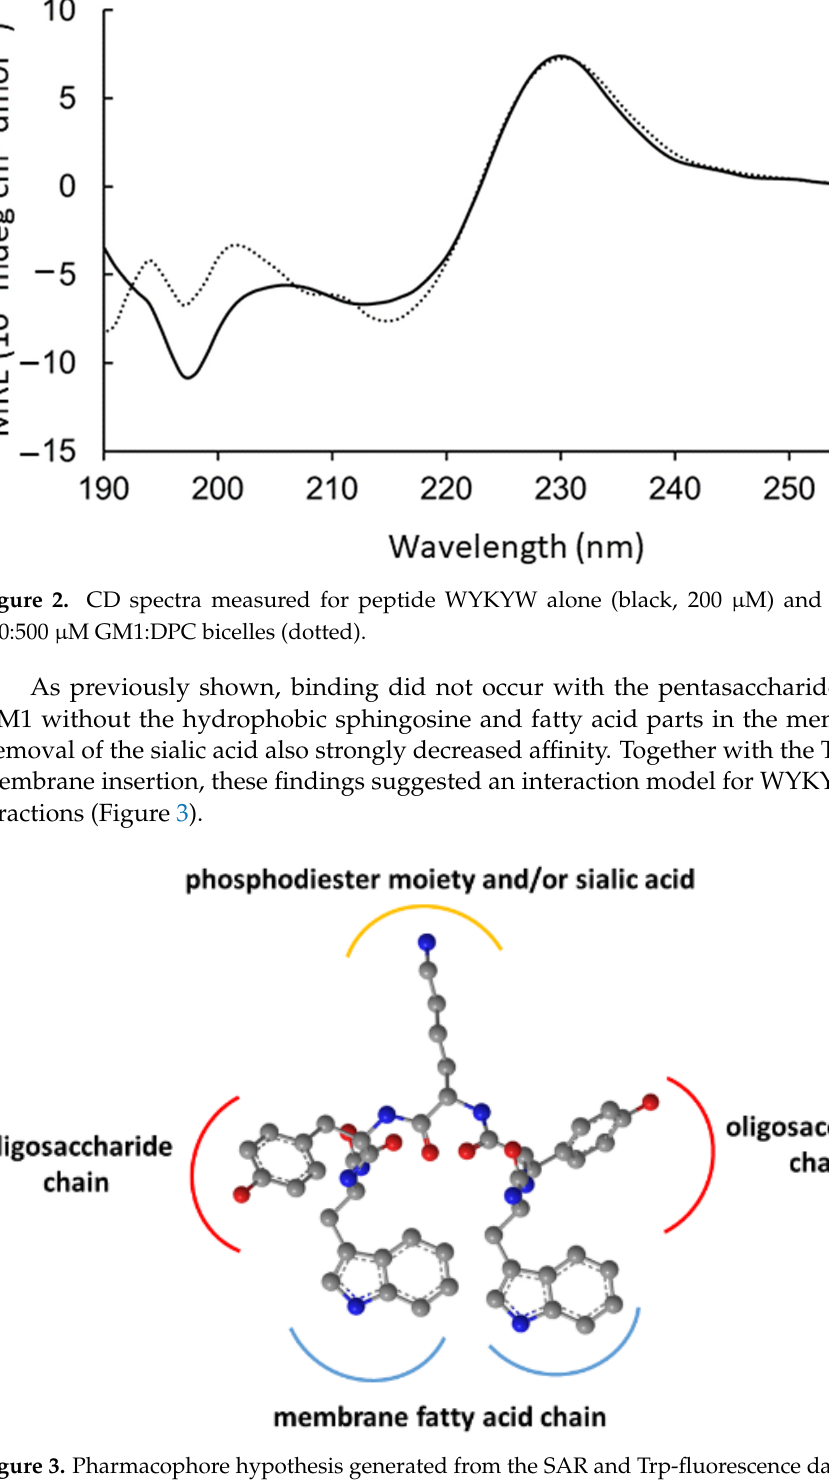
Figure 3. Pharmacophore hypothesis generated from the SAR and Trp-fluorescence data.